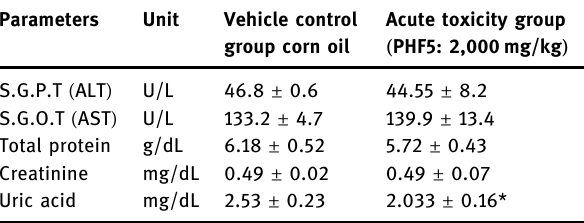
Table 1: E ff ect of PHF5 extract at the dose of 2,000mg/kg body weight on total protein, creatinine, uric acid, ALT, and AST in female mice Parameters Unit Vehicle control group corn